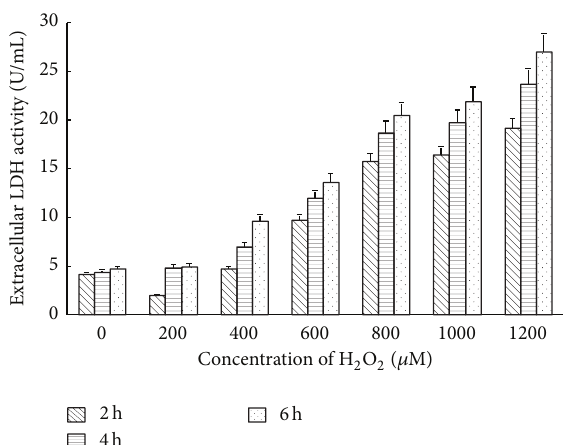
Figure 3: Effect of H 2 O 2 on leakage of LDH in SK-N-SH cells.